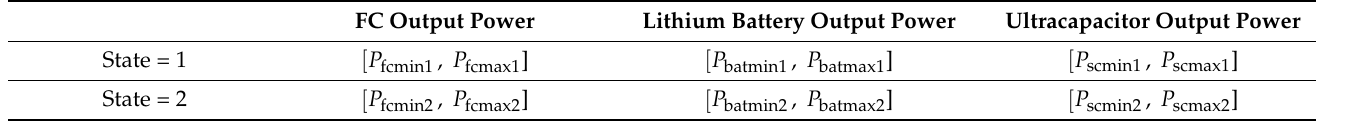
Table 4. Improvement strategy table.